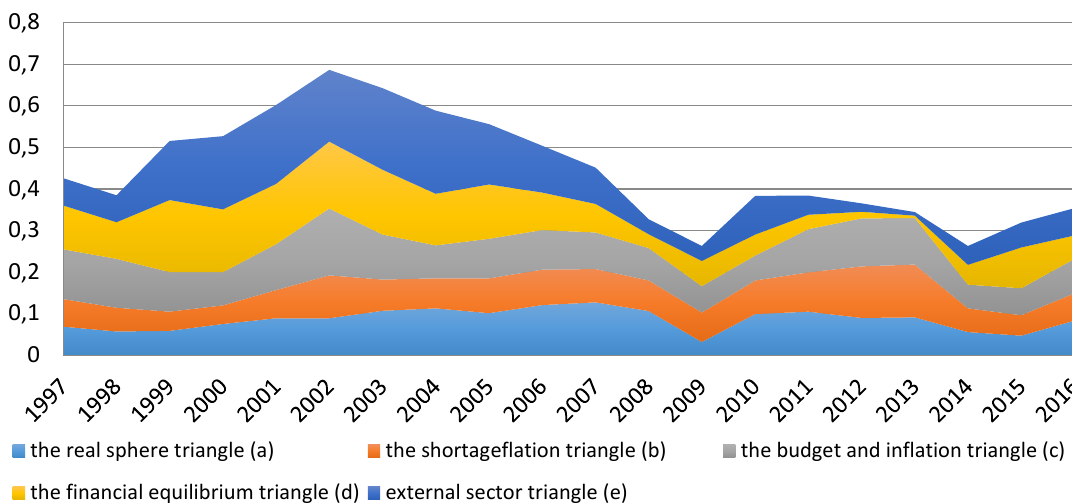
Figure 4. Distribution of MSP for Ukraine in